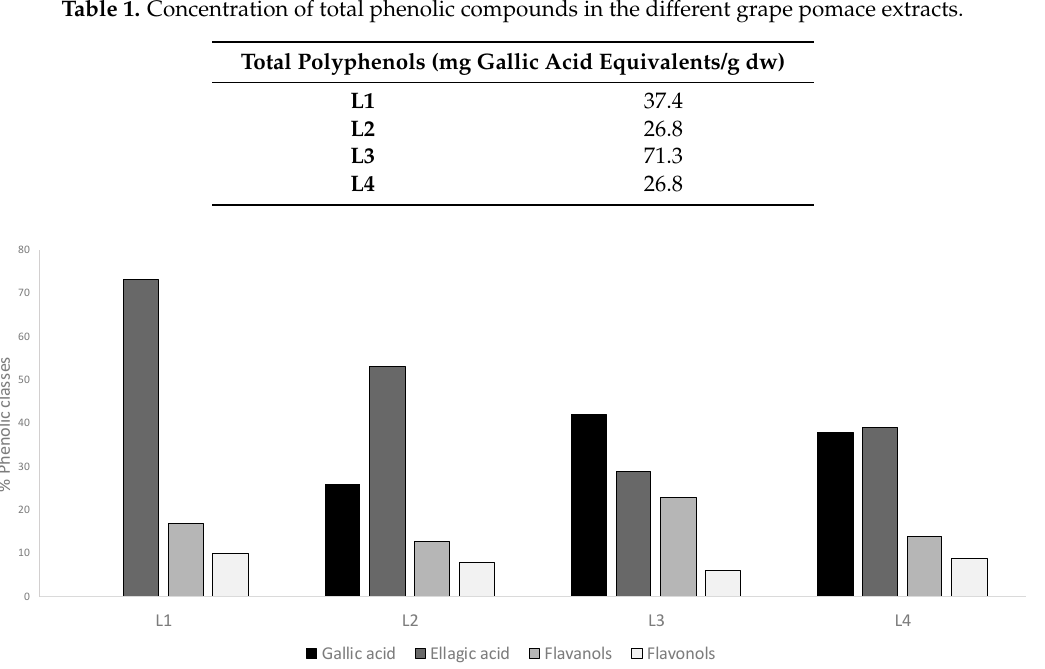
Figure 1. Percentages of distribution of phenolic classes in the studied grape pomace extracts, as calculated from the results that were reported by Gil-Sanchez et al. (2017) [12].